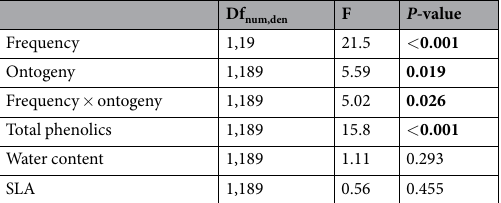
Table 2. Summary of results from mixed models testing for the effects of neighbourhood type (high- vs low- frequency of Quercus robur ), ontogenetic stage (adult trees vs. saplings), their interaction, and the effects of leaf chemical defences (total phenolics, mg g − 1 d.w.) and leaf physical traits (proportion of water content and specific leaf area [SLA]) on insect leaf herbivory in Q. robur . Herbivory was estimated as the proportion of leaves damaged by insect herbivores for two randomly chosen low-hanging branches. These data were logit- transformed to achieve normality of residuals. Site and site × neighbourhood type were included as random factors. F-values, degrees of freedom and associated P -values of fixed factors are reported. Significant P -values ( P < 0.05) are typed in